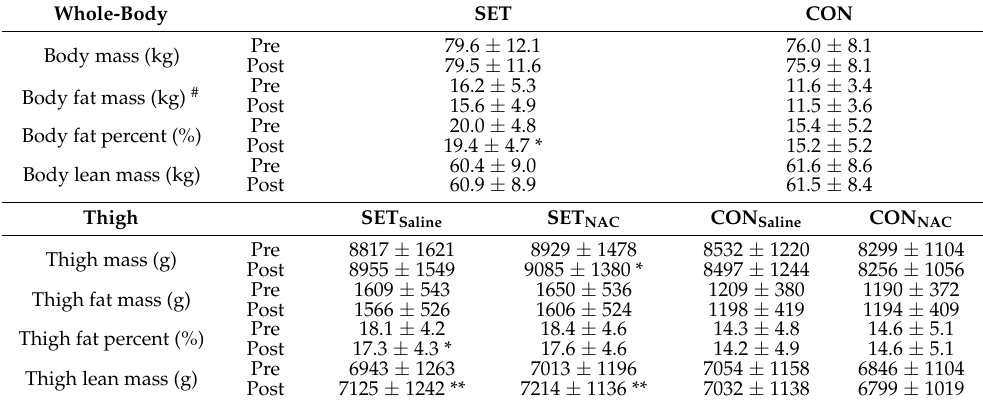
Table 2. Whole-body and thigh composition before and after speed endurance training (SET) or habitual lifestyle maintenance (CON).